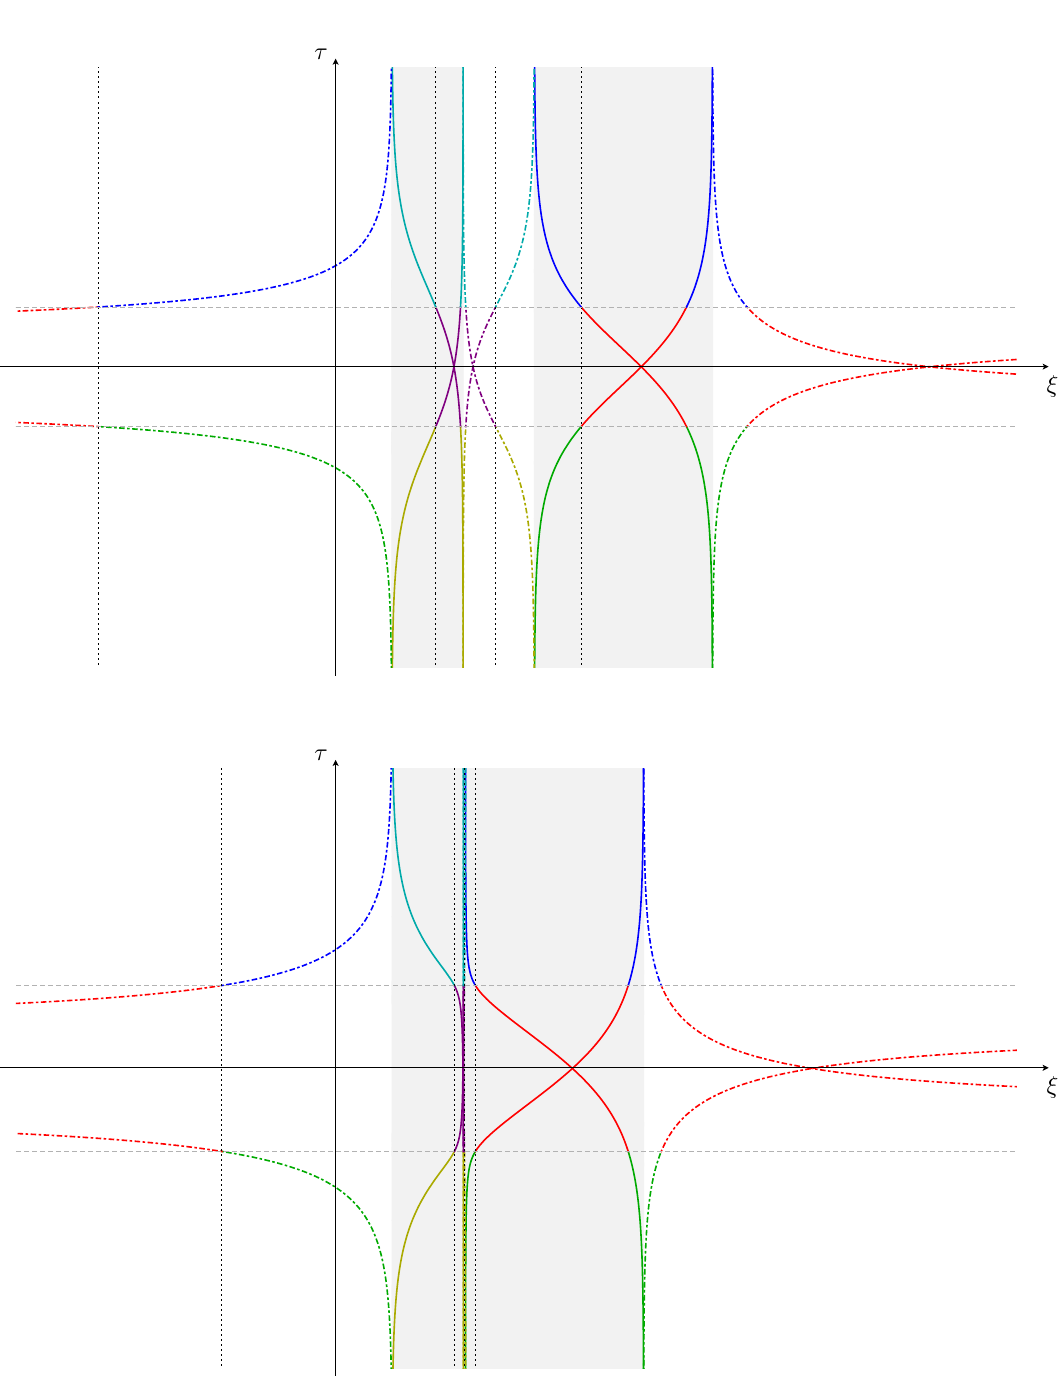
Figure 10 . The curves ξ ( τ, x ) and ξ ( − τ, x ) (solid lines) and their images under the inversion map (dot-dashed lines) in the plane ( ξ, τ ) , obtained from (7.9) and (7.26). The vertical dotted lines in the grey strips correspond to (7.16) and (7.18). The bottom panel illustrates the limiting regime of adjacent